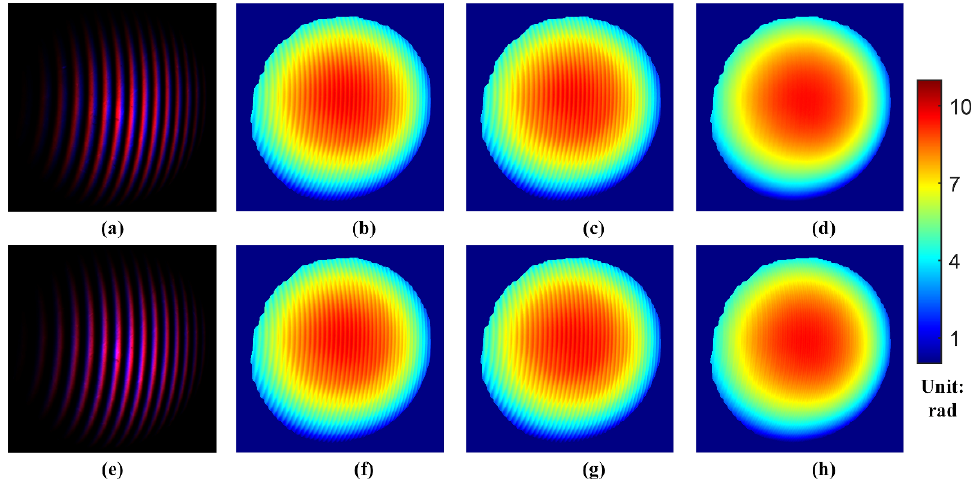
Figure 6. Comparison results of the sphere. ( a ) Distorted color fringe for the proposed IDTP algorithm, and the absolute phases recovered from ( b ) the red channel, ( c ) the blue channel, and ( d ) the average fringe, respectively. ( e ) Distorted color fringe for the conventional PDTP algorithm, and the absolute phases recovered from ( f ) the red channel, ( g ) the blue channel, and ( h ) the average phase,